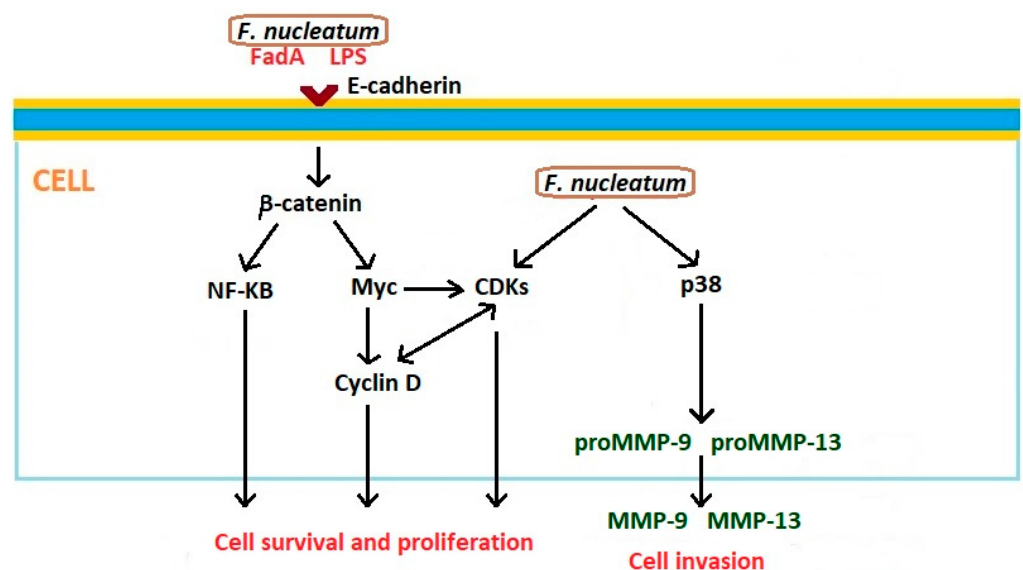
Figure 3. Interactions between Fusobacterium nucleatum and epithelial cells that can affect development of oncogenic phenotype. Based on Gholizadeh et al. [58] and Whitmore and Lamont [61]. CDK: cyclin ‐ dependent kinase; FadA: fusobacterial adhesin/invasin; LPS: Lipopolisaccharide; MMP: metalloproteinase; NF ‐ kB: nuclear factor kappa B; p38: Mitogen ‐ activated protein kinase p38.